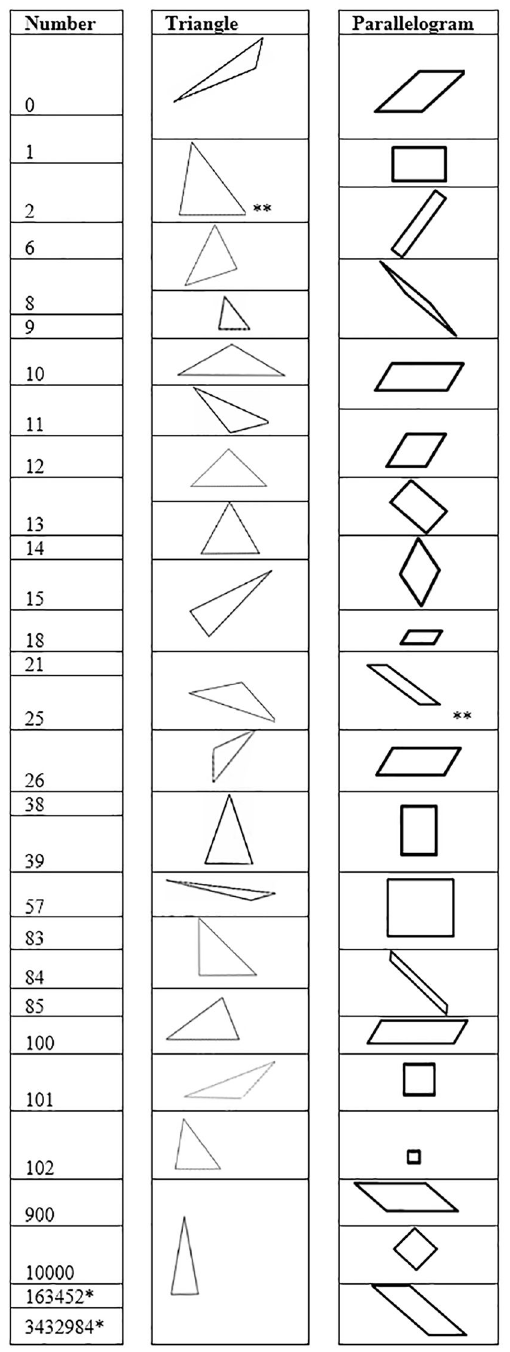
Figure A1. Items used on surveys. *These items were on the mathematician survey but not the middle school student survey. **These items were on the middle school student survey but not the mathematician